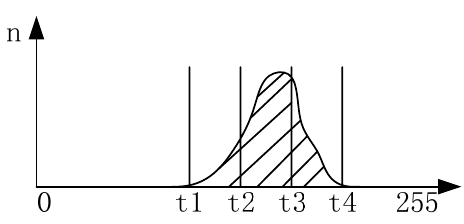
Figure 11. Choice of the feature